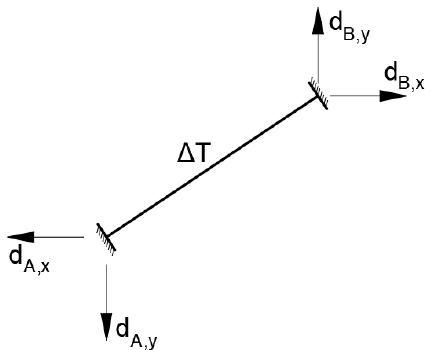
Figure 8. Strand loading scheme: Δ T— uniform temperature change; d i,j —theoretical anchorages displacements.